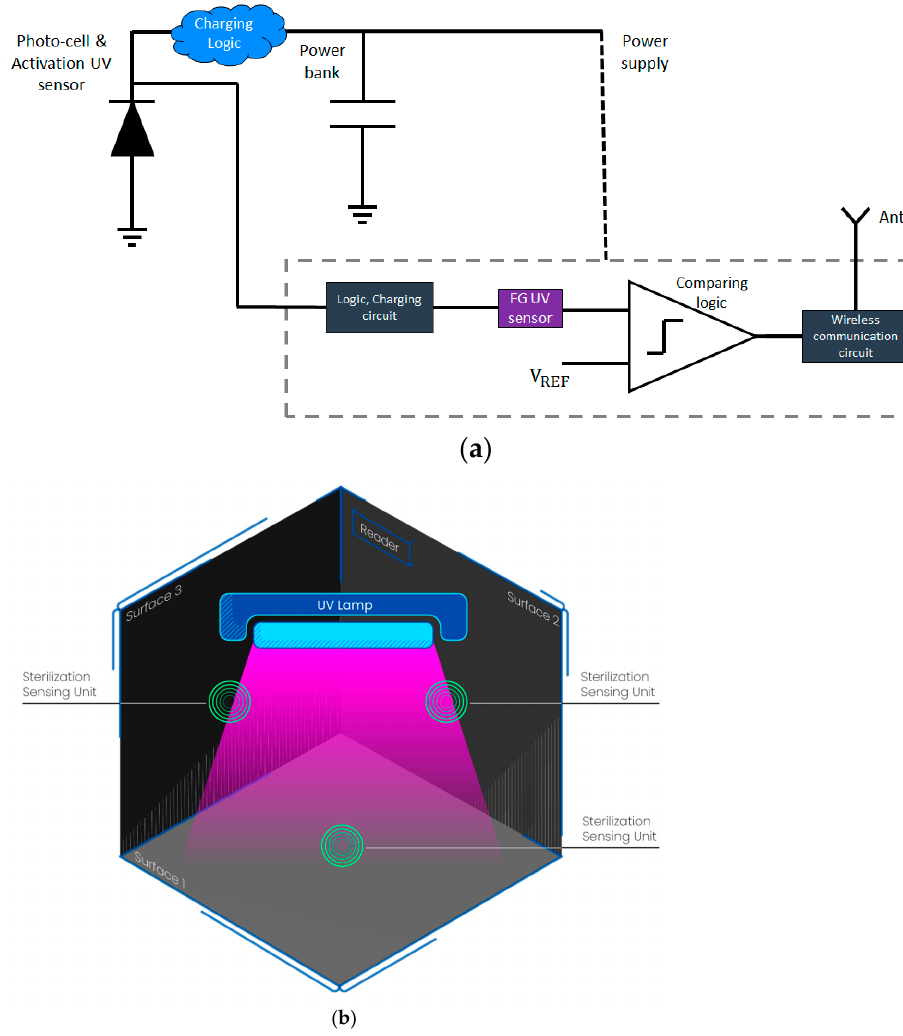
Figure 5. ( a ) UV sensor edge unit schematic (integrated FG UV sensor) ( b ) Disinfection system with multiple edge units, (illustration).